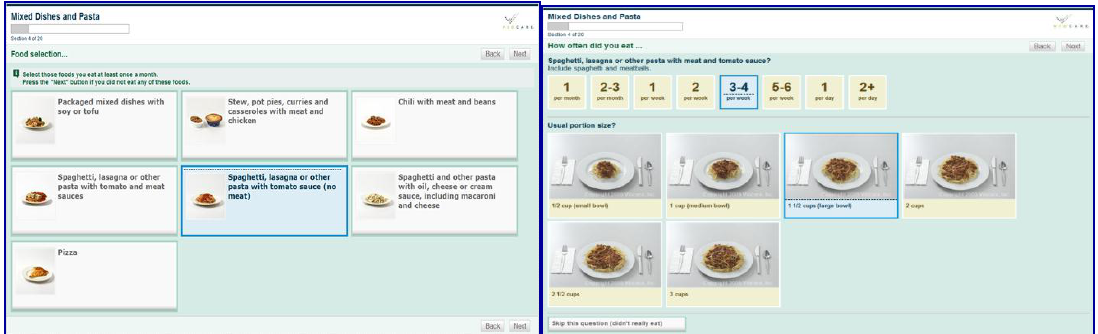
Figure 1. Examples of screens from the VioScreen food frequency questionnaire (FFQ) showing food selection choices and portion size options.